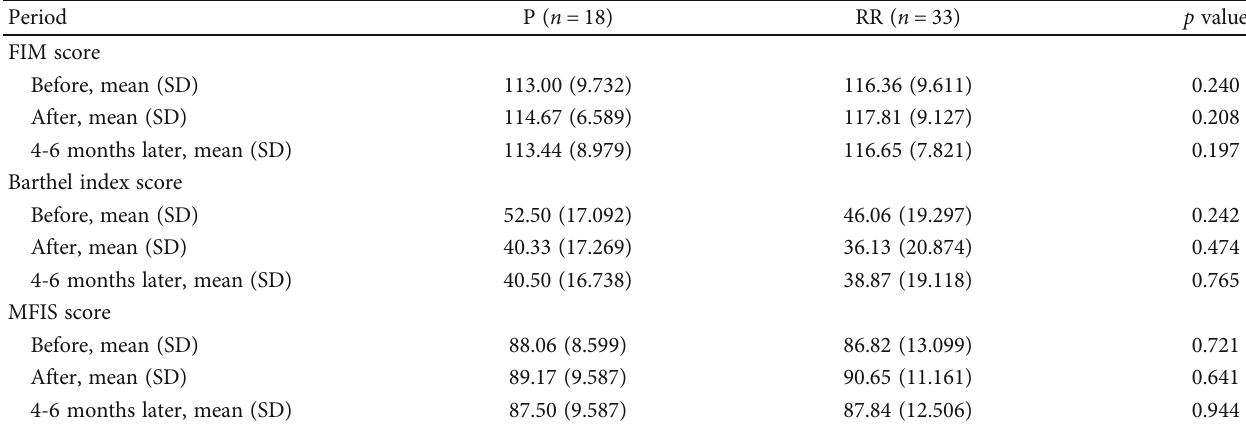
Table 3: Di ff erences in FIM score, Barthel Index, and MFIS scores between progressive and relapsing-remittent